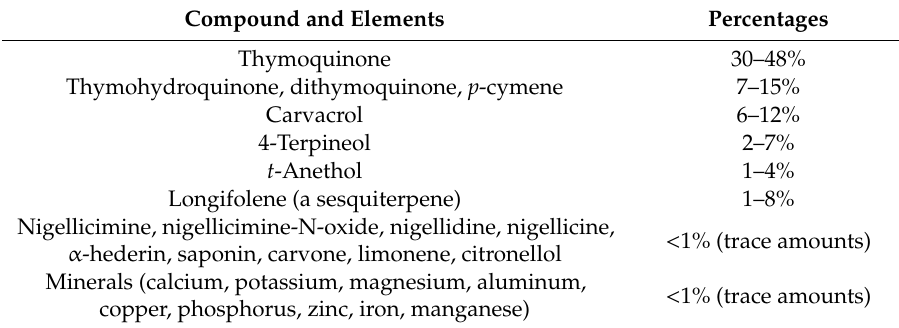
Table 1. Active compounds and elements isolated from Nigella sativa seeds and their percentages. Compound and Elements